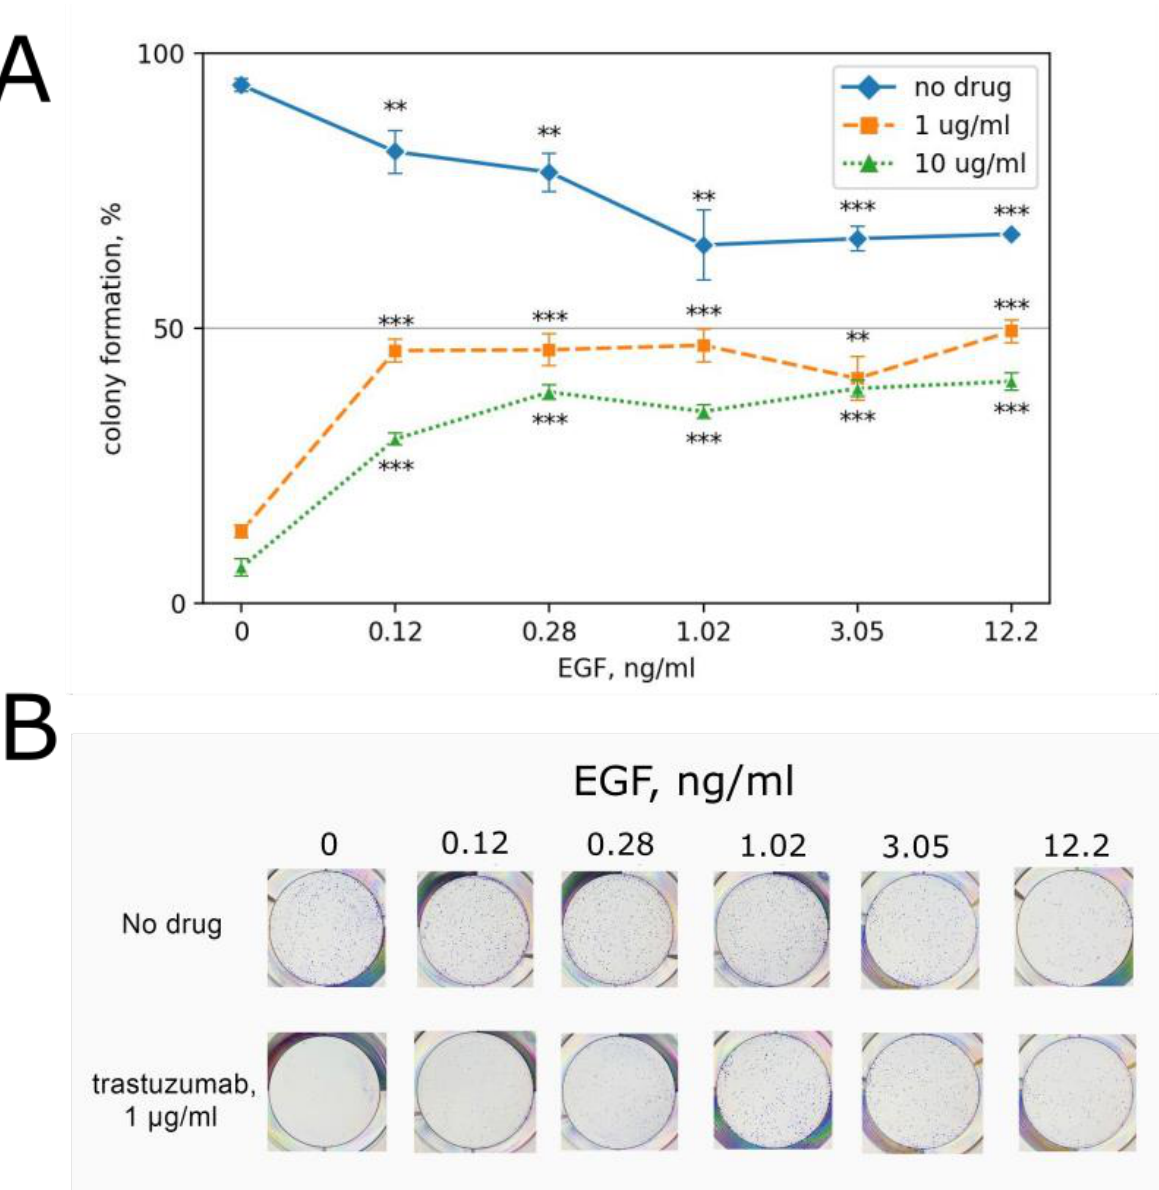
Figure 4. ( A ) EGF concentration dependence of BT474 clonogenicity in the absence and in the presence (1 µg/mL and 10 µg/mL) of trastuzumab. Clonogenicity is normalized in the results for the control growth medium without trastuzumab. ( B ) Representative photographs of stained clonogenicity assay results were used for colony number calculations. ** — p -value < 0.01; *** — p -value < 0.001. In our experiments, BT474 cells clonogenicity decreased to ~64% in the presence of EGF at concentrations exceeding 1 ng/mL compared to non-drug level. Clonogenicity did not significantly depend on EGF concentration between 1 and 100 ng/mL of EGF (Figure The anti-HER2 drugs are known to inhibit cell-cycle progression by causing the G1 4), in contrast to A431 cells, whose growth could be completely inhibited by EGF concen- trations starting from 35 ng/mL [60]. BT474 cells are highly sensitive to trastuzumab with activated cell sorting (FACS) analysis. In 10 ng/mL trastuzumab treated cells, we observed a G0/G1 phase shift to 72.8% from the baseline of 66.9% (Table 1). This treatment inhibited cell growth to only 7% of the baseline level in the clonogenicity tests. When trastuzumab